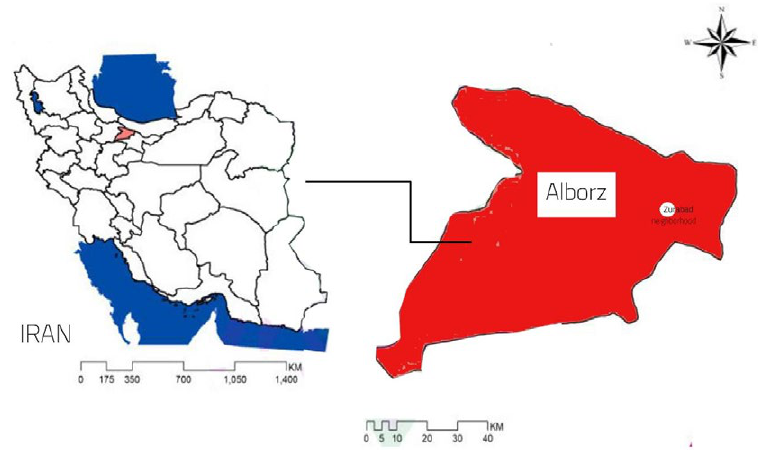
Fig.1: Iran, Alborz province (Map of karaj, 2019